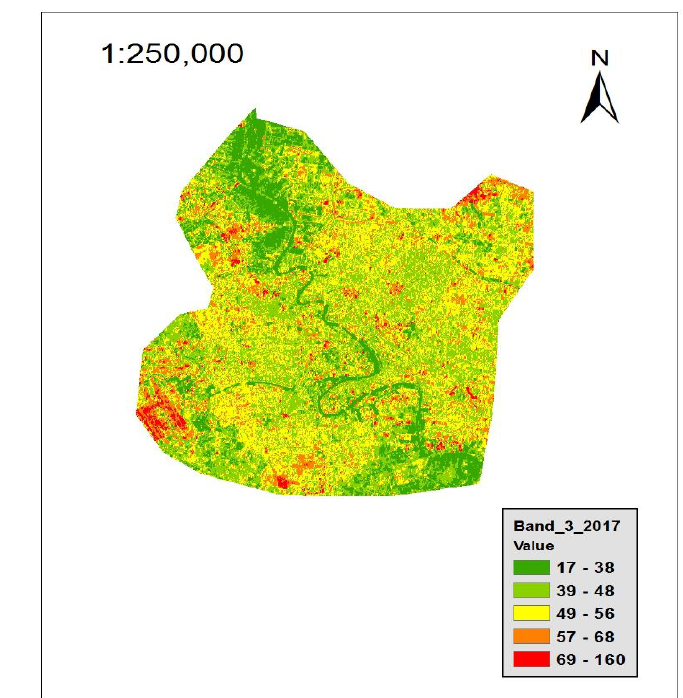
Fig.13: Show image classification of band (3) for study area in date (27/11/2017).